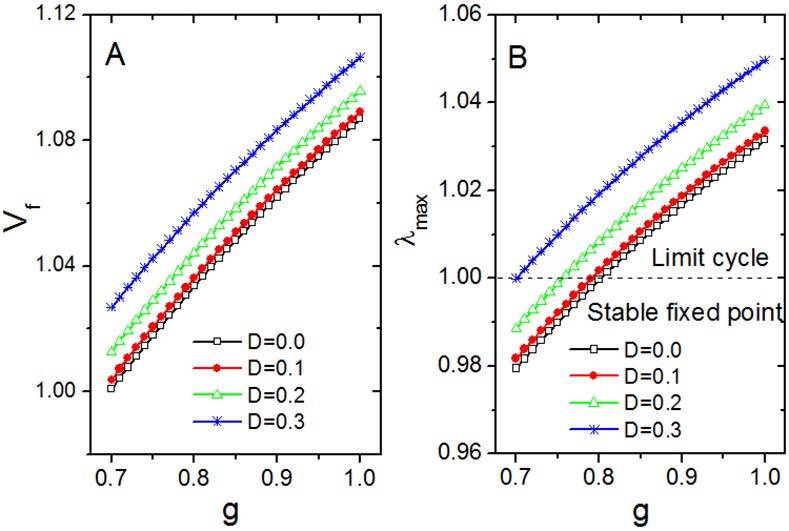
Stability analysis of the fixed points for four noise intensities.(A) The fixed points represented by the marker V
f versus coupling strength g for four different values of noise intensity D. (B) The maximal real parts λ
max of the eigenvalues of the Jacobian matrix of the Eq 3 versus coupling strength g for four different values of noise intensity D. The dashed line of λ
max = 1 divides the investigated area into two regions, in one of which the fixed points are stable due to λ
max < 1, and in the other where the fixed points are unstable due to λ
max ≥ 1 and limit cycles (oscillations) emerge.